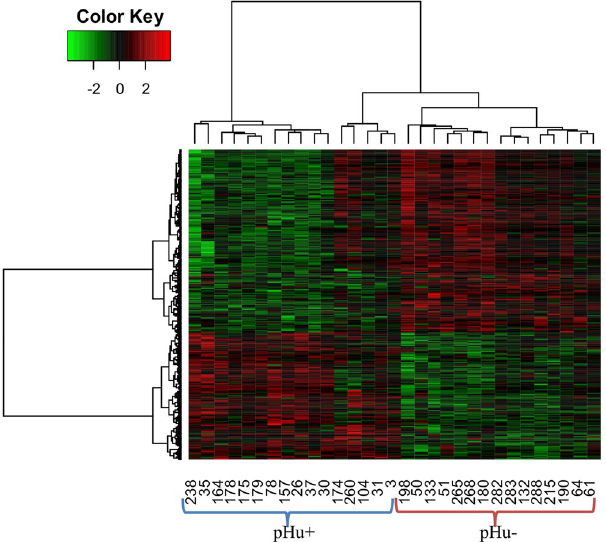
Figure 2. Heat map from the hierarchical clustering of differentially expressed genes between the pHu − and pHu + individuals. The scaled expression by row (gene) is shown as a heat map and is reordered by a hierarchical clustering analysis (Pearson’s distance and Ward’s method) on both rows and columns.